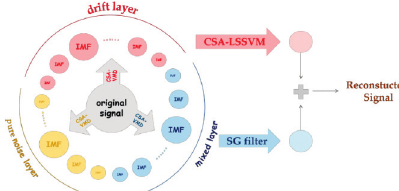
Figure 7: The flowchart of CSA-VMD-SG-LSSVM model.